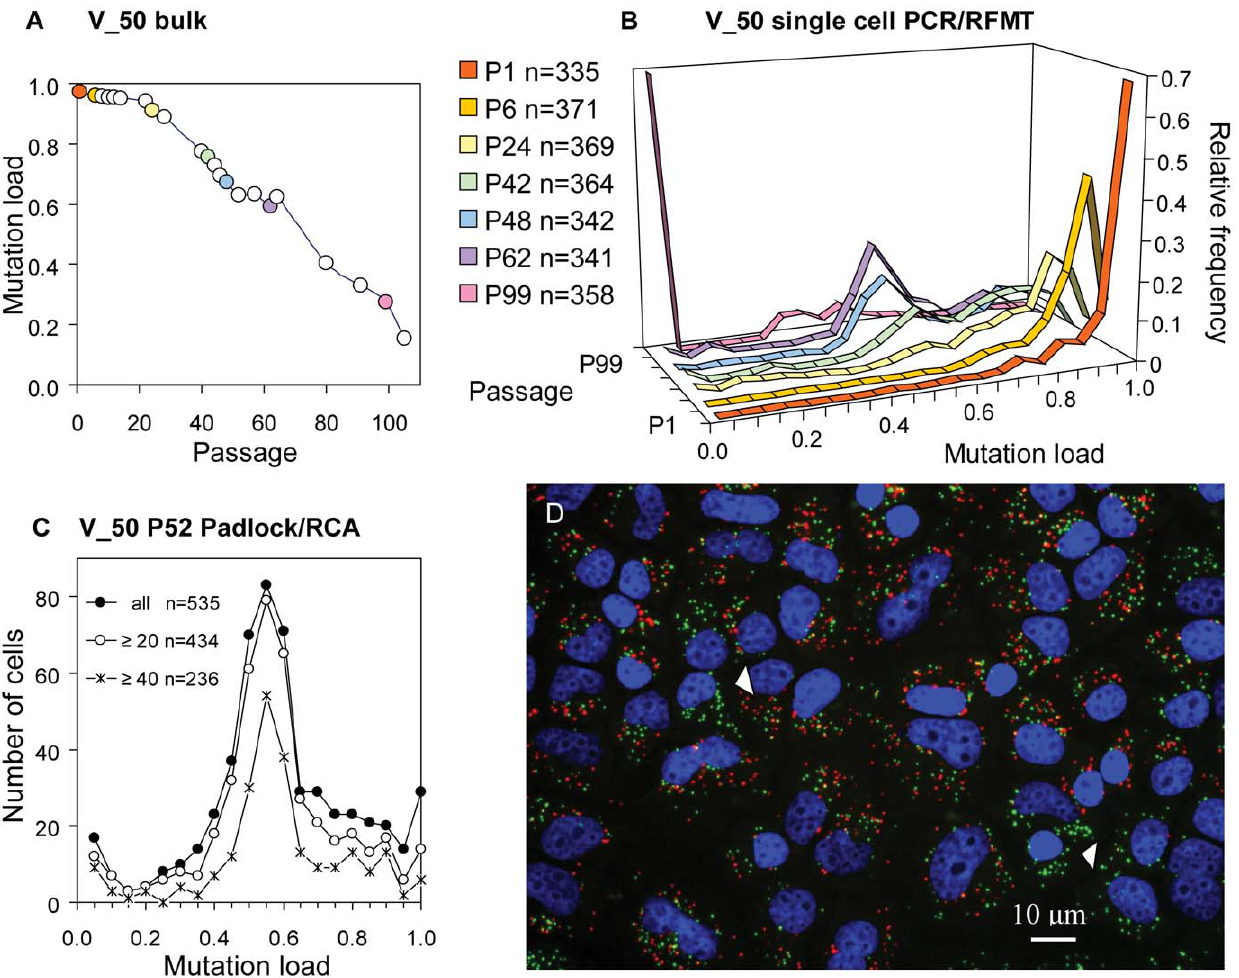
Figure 2. Heteroplasmy evolution of cybrid clone V_50. (A) Average cellular mutation load decreases with increasing passage number of clone V_50. Conventional gel-based PCR-RFLP was used for quantitation of the m.3243A . G heteroplasmy. (B) Relative mutation load PCR-RFMT histograms of flow sorted single cells of selected passages of clone V_50. n refers to the number of single cells evaluated in the histogram. (C) Frequency histograms of m.3243A . G Padlock/RCA mutation loads of cells in V_50 P52 at increasing stringency of the dots/cell number criterion, cells with . 0 (all), $ 20 and $ 40 dots/cell. See Figure S1 for choice of stringency and bin size. (D) Microscopic image of V_50 P52 after m.3243A . G Padlock/RCA in situ genotyping. Note in this microscopic field the presence of homoplasmic wild type cells (arrow heads) amidst the heteroplasmic cells. See Figure S2 for discussion on the number and nature of the signals.